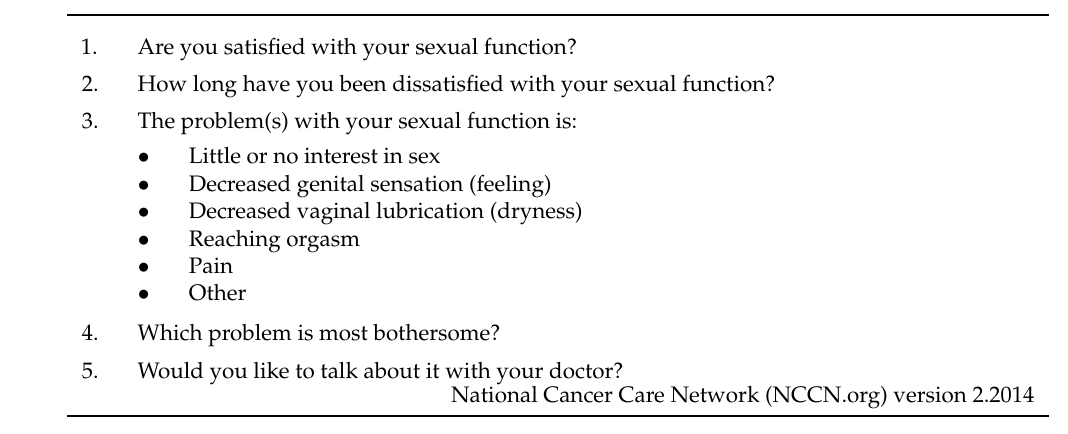
Table 2. Brief Sexual Symptom